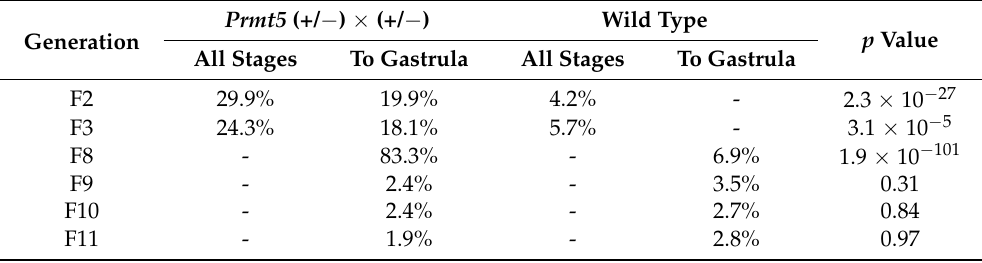
Table 2. The death rate of the embryos in different stages and different generations. Generation